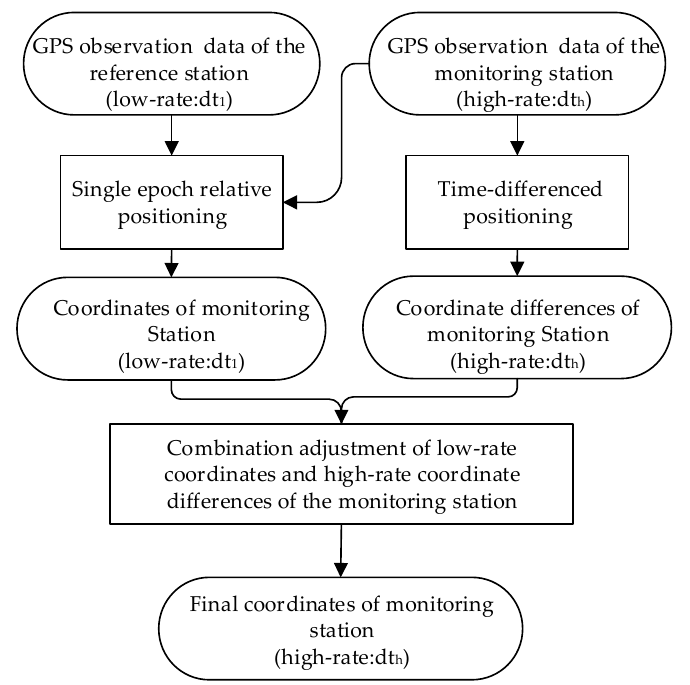
Figure 2. Data processing of combining high- and low-rate GPS position.